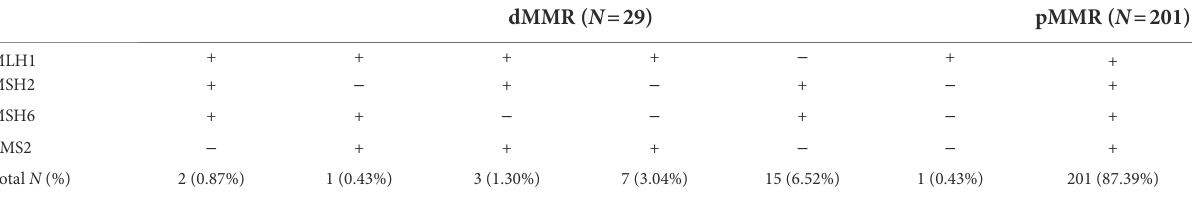
TABLE 1 MLH1, MSH2, MSH6, and PMS2 protein expression in colorectal